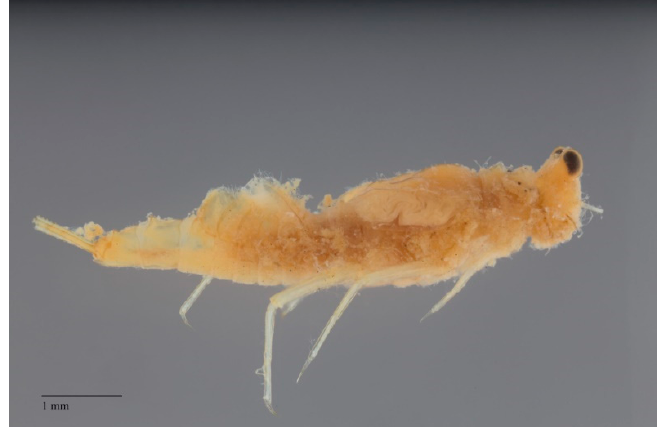
Figure 9. Caenis luctuosa (Burmeister) (Caenidae, Switzerland) in dorsal view; the second pair of gills is operculate and protects the delicate subjacent ones.